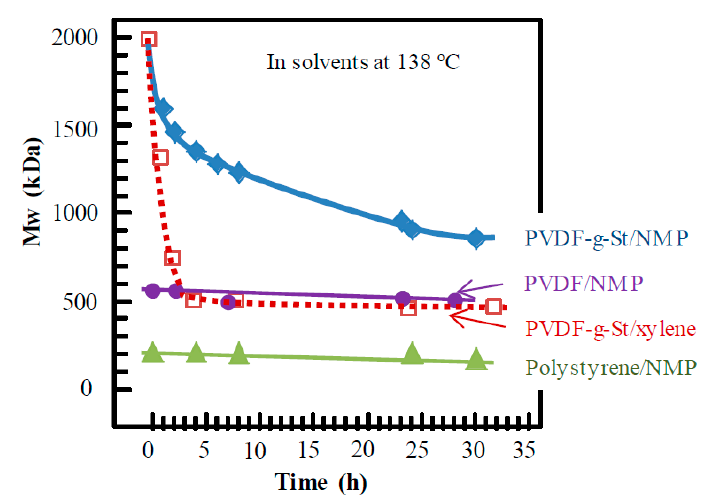
Figure 10. Weight-average molecular weight ( M w ) of the PVDF-g-St film, pristine PVDF and commercial polystyrene in NMP (bond symbols and lines) and the residual PVDF– g –St film in xylene (bulk symbols and dotted line) at 138 ° C as a function of treatment time.